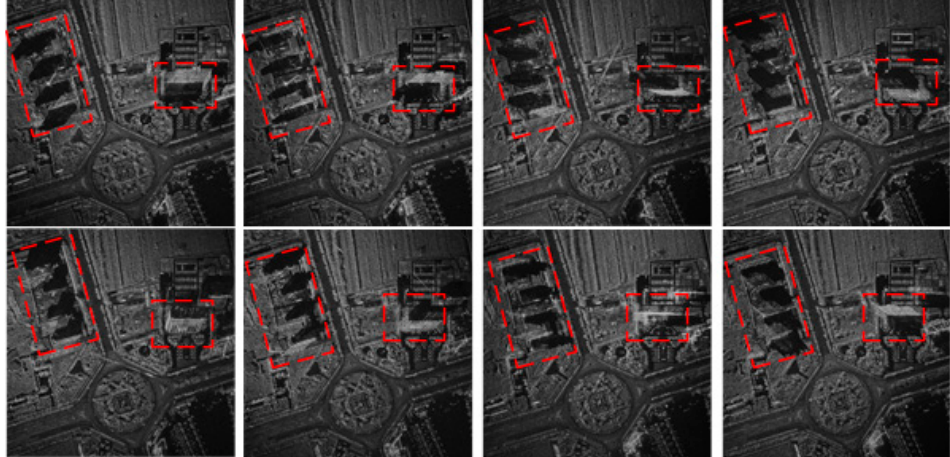
Figure 25. Imaging results of different frames. The azimuth angles, from left to right then from up to down, are 30 ◦ , 5 ◦ , 335 ◦ , 260 ◦ , 230 ◦ , 190 ◦ , 165 ◦ and 100 ◦ respectively.